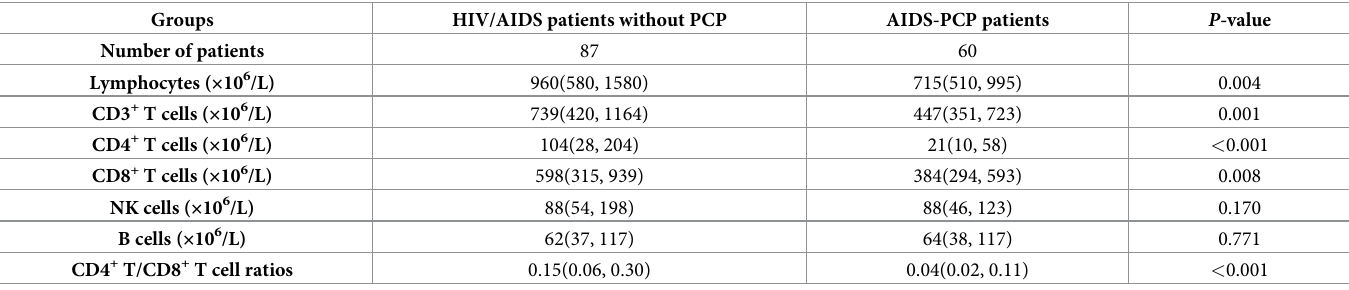
Table 3. Comparison of peripheral blood lymphocyte subsets in HIV/AIDS patients with and without PCP.